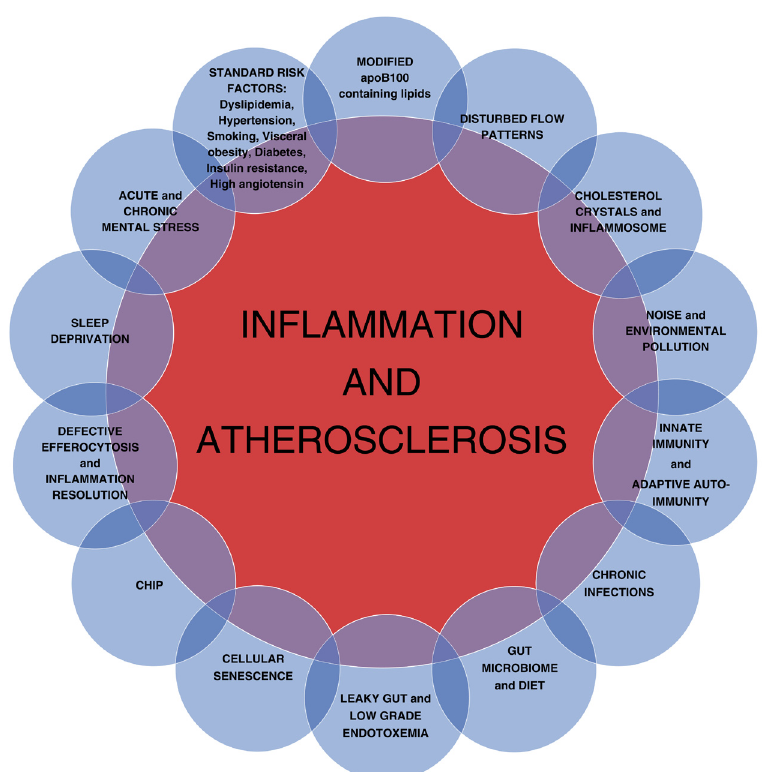
Figure 1. Different pathways for inflammation in athrosclerosis are depicted in this figure. (CHIP, clonal hematopoetic mutations of indeterminate potential).